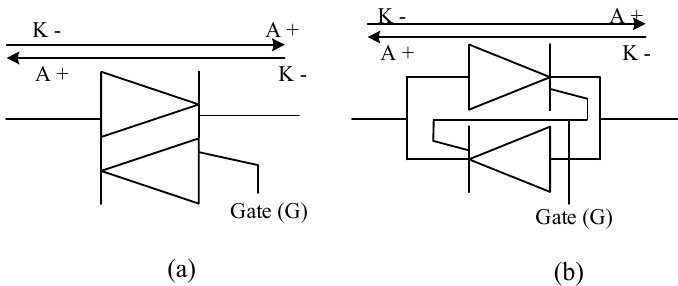
Figure 12. Schematic symbol of ( a ) a triode ac switch (Triac) and ( b ) the detailed depiction of a Triac’s formation from two SCRs [138].